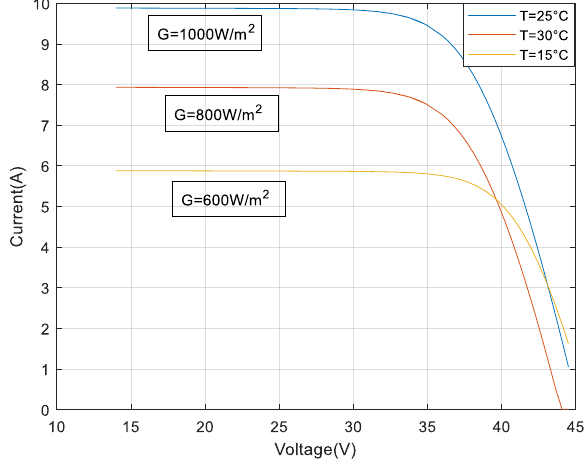
Figure 8. PV panel I-V characteristic.